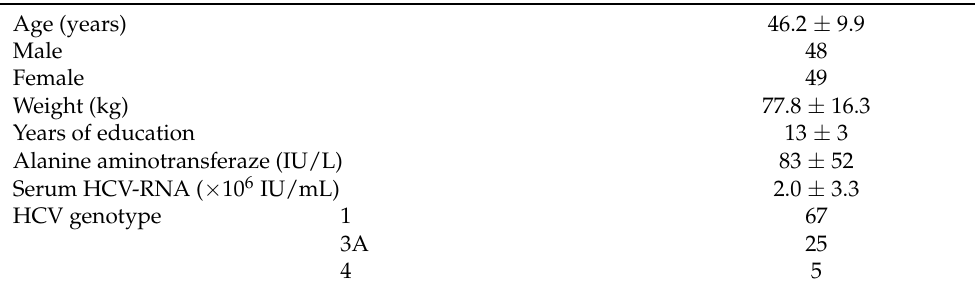
Table 1. Sociodemographic characteristics of HCV patients treated with PEG-IFN- α 2a/RBV (N = 97) (all values are given as mean ±